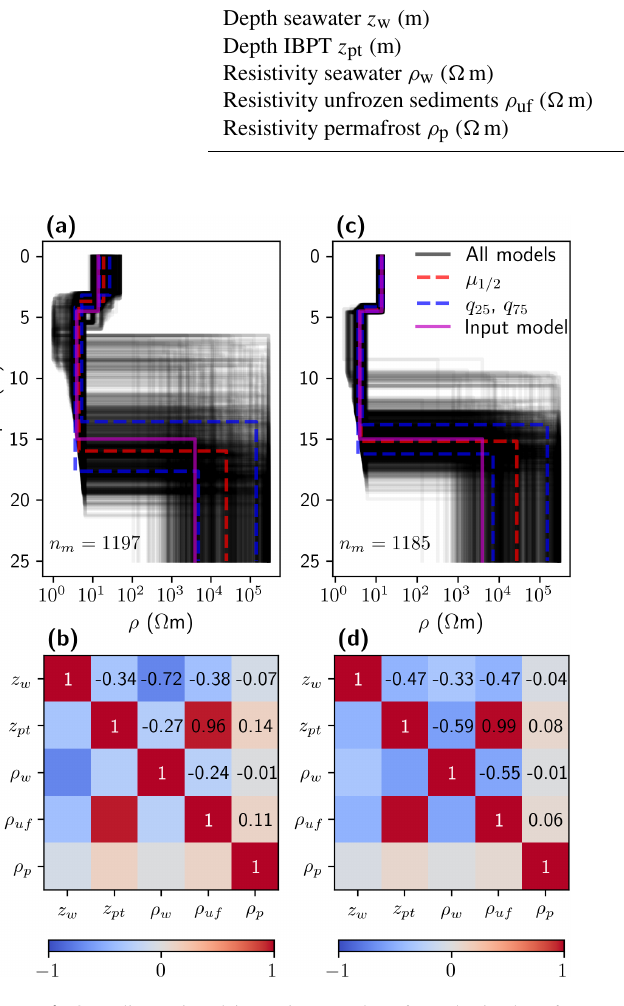
Figure 4. One-dimensional inversion results of synthetic data for 1D subsurface scenarios developed for the Bykovsky field site. (a) Ensemble with n m model solutions and (b) the corresponding symmetric correlation matrix for scenario 1 (water layer parameters with large freedom during inversion) and (c–d) the same for sce- nario 2 (with constrained z w and ρ w ). Black lines in panels (a) and (c) are plotted with transparency, and, therefore, the darker areas indicate higher densities model. The numbers in panels (b) and (d) are the corresponding correlation